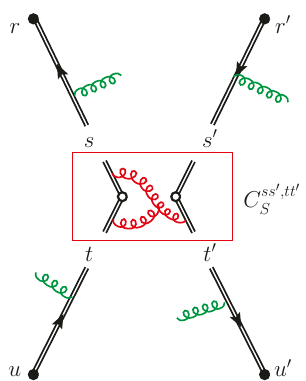
Figure 7. Interactions of Wilson lines in the operator O S,a ( y , z ) in the limit of small z . Short- distance interactions are located in the box at the centre, whereas gluons outside the box indicate possible interactions with other Wilson lines at distances much larger than z . In the soft factor S a ( z i , y ) these distances are of order y for small z 1 and z 2 1 a 2